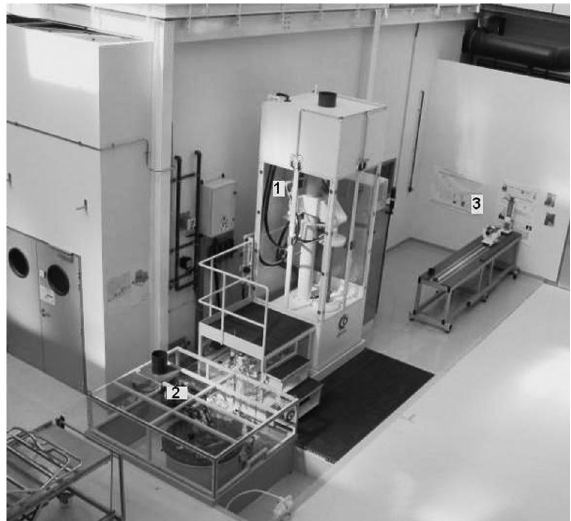
FIG. 1. VEP setup at CEA Saclay. 1: Main cabinet for cavity treatment. 2: Acid tank located in a pit. 3: Table for assembly prior to